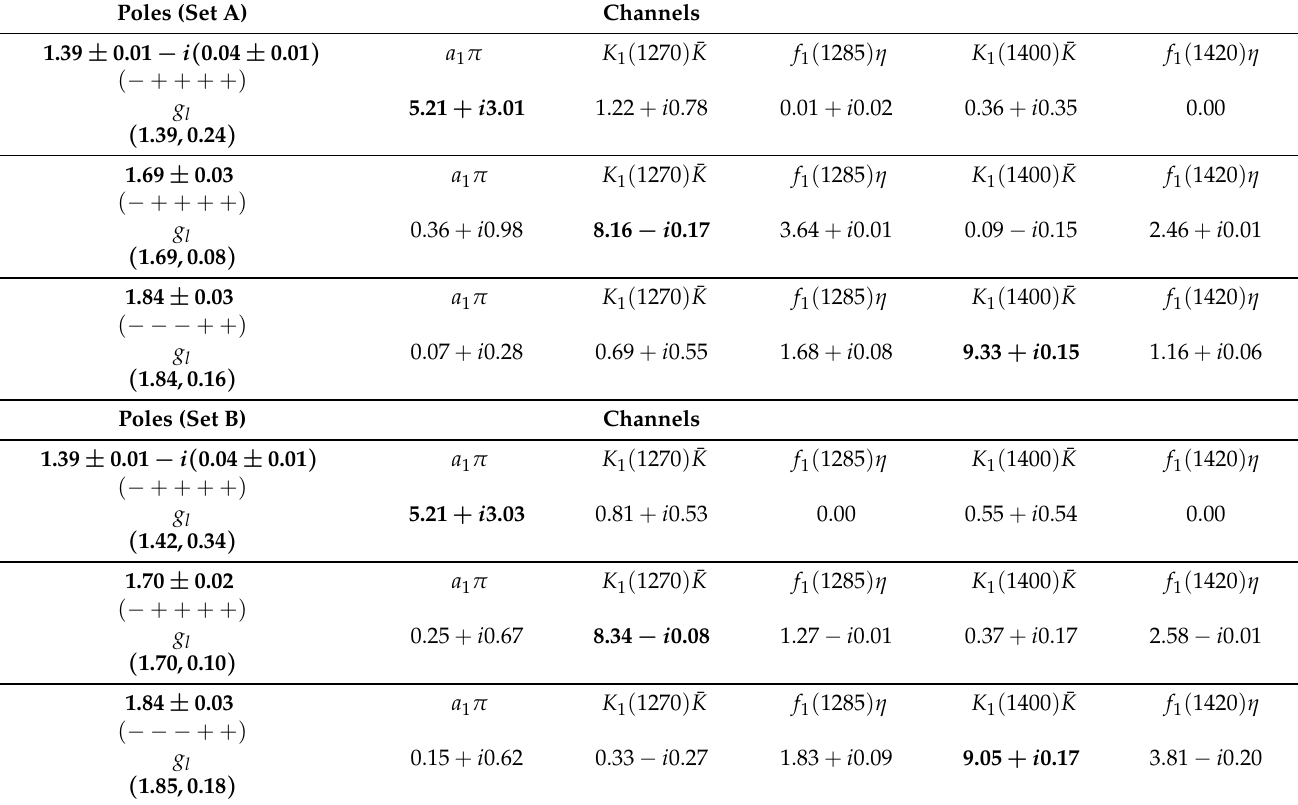
Table 10. The poles (in GeV) and their corresponding couplings (in GeV) to the channels contributing to the PA interaction with I = 0 and exotic quantum numbers J PC = 1 − + . The corresponding Riemann sheet for each pole is listed below the pole position. The dominantly coupled channel is emphasized in boldface for each pole. The errors of the poles are from varying the subtraction constant within α ( µ = 1GeV ) = 1.35 0.17, and only the central values of the couplings are − ± given. For each pole, we also give the central values of the peak mass and width as ( M peak , Γ peak ) , after considering the axial-vector meson widths, in the last row of the corresponding